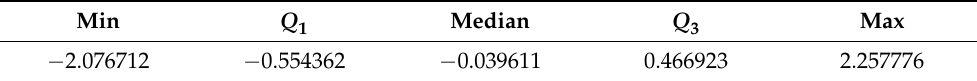
Table 2. Statistics of Zscore.